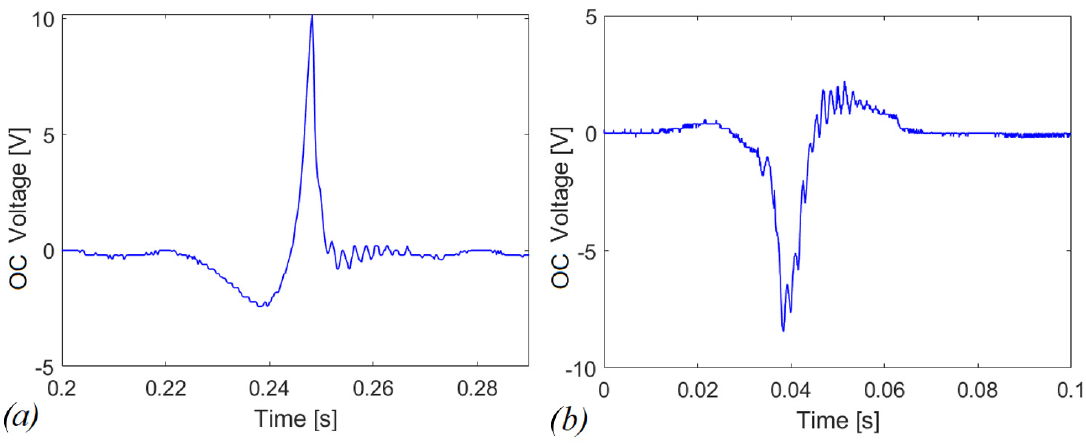
Figure 9. Open-circuit voltage in case of ( a ) repulsive and ( b ) attractive plucking for a single snap.